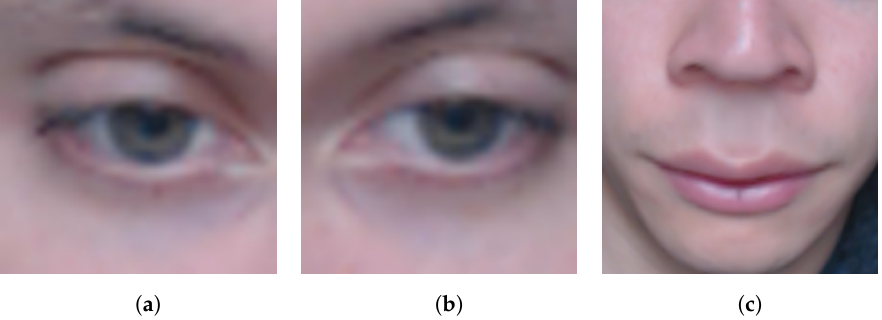
Figure 4. Exemplification of the frames of the ROIs. ( a ) ROI image of the right eye. ( b ) ROI image of the left eye. ( c ) Image of the lower face